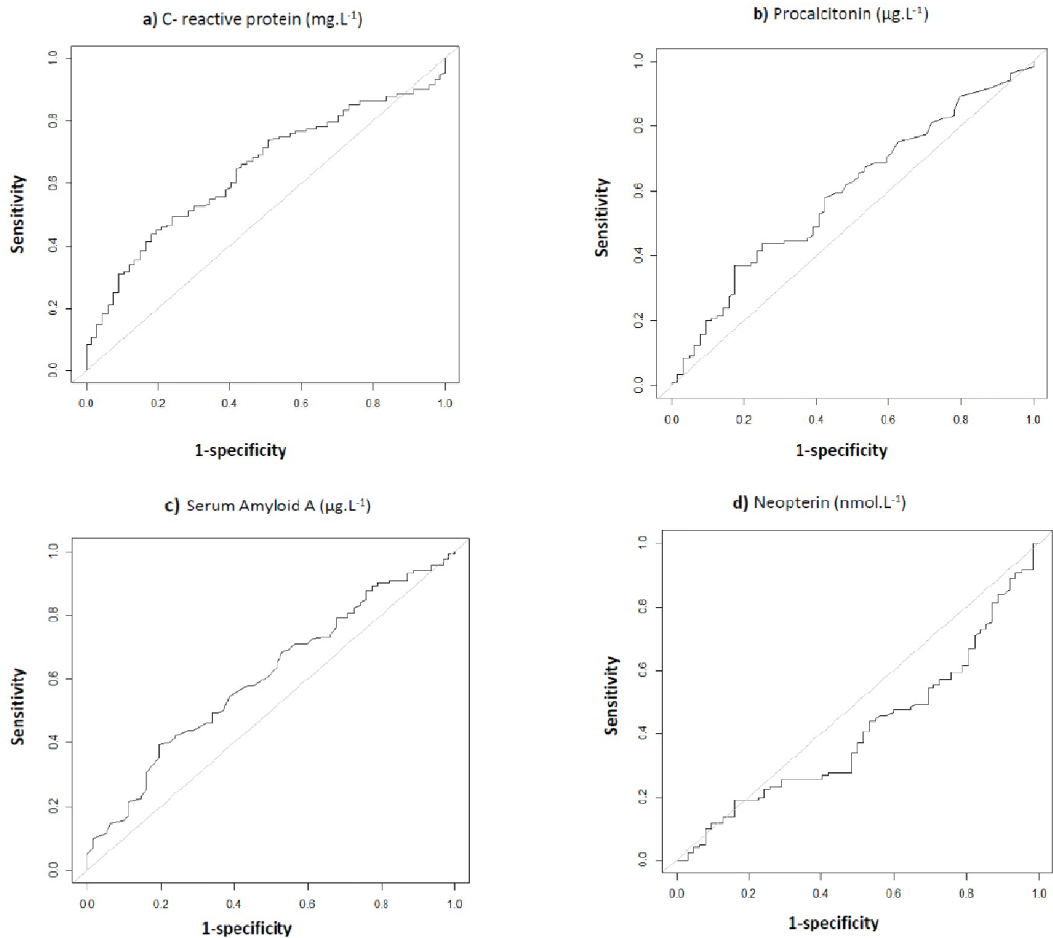
Fig 2. ROC curves for the diagnosis of pneumonia. a) C-reactive protein Area under the curve [95% CI] = 0.64 [0.56–0.72]. Optimal cut-off point at 109.4 mg.L -1 . b) Procalcitonin Area under the curve [95% CI] = 0.59 [0.51–0.68]. Optimal cut-off point at 1.06 μ g.L -1 . c) Neopterin Area under the curve [95% CI] = 0.41 [0.32–0.49]. Optimal cut-off point at 16.4 nmol.L -1 . d) Serum amyloid A Area under the curve [95% CI] = 0.60 [0.52–0.69]. Optimal cut-off point at 15.3 μ g.L -1 .